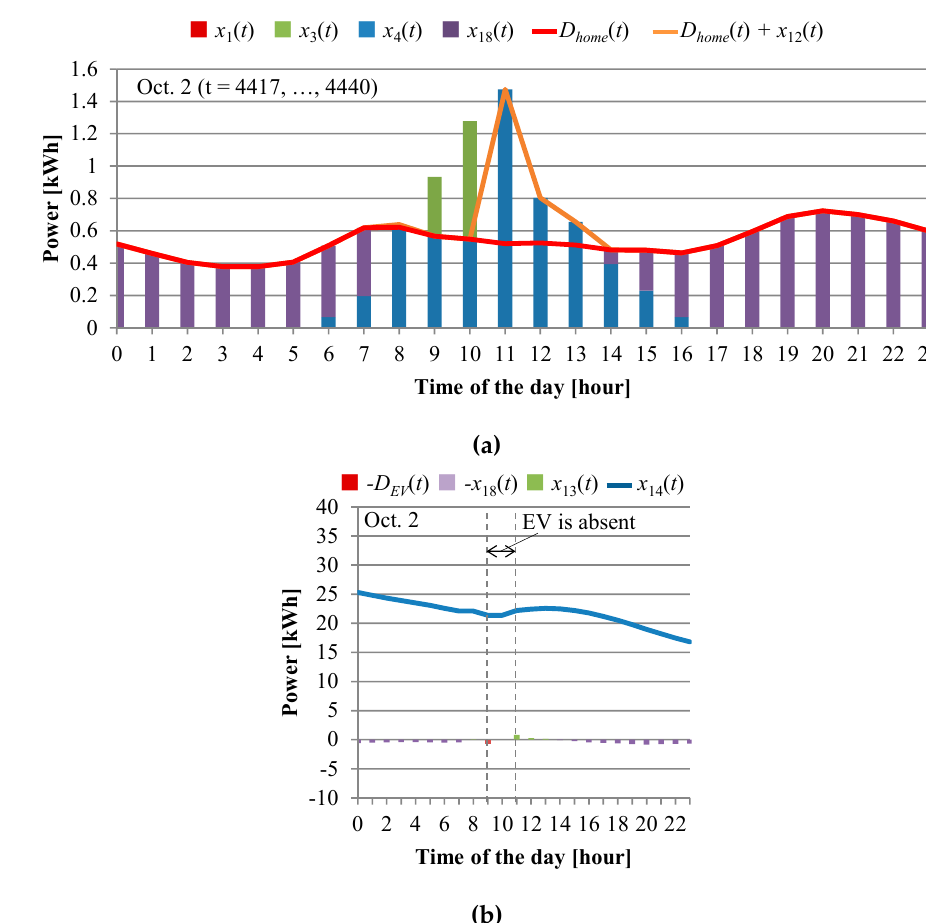
Figure 12. Optimized energy flow in case 4 on the day with small amount of PV power generation ( a ) residential supply-demand balance and ( b ) operation schedule of EV battery with V2H. Focusing on CO 2 minimization, Figure 13 shows that the PV and SB sizes reached the installation upper limits to reduce the use of grid power as far as possible. The self-consumption rate, r sc , shown in Figure 9 is calculated by Equation (37).